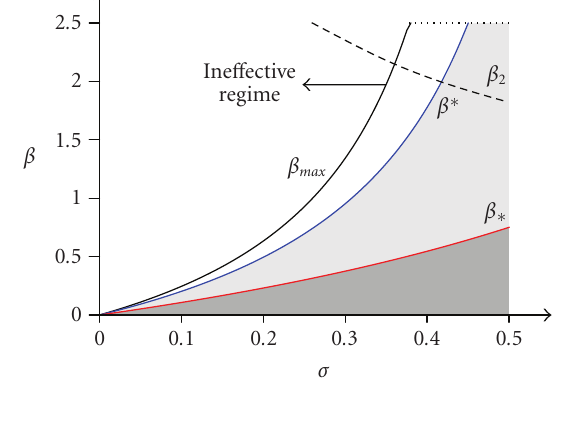
Figure 5.2. Critical β